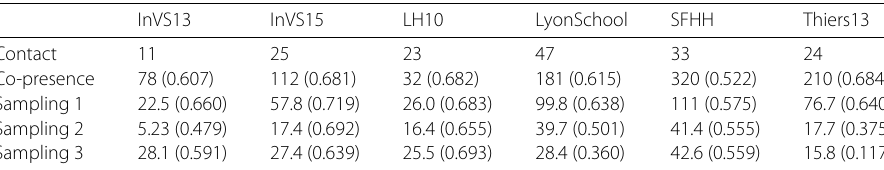
Table 5 Comparison of the maximum k -core properties InVS13 InVS15 LH10 LyonSchool SFHH Thiers13 Contact 11 25